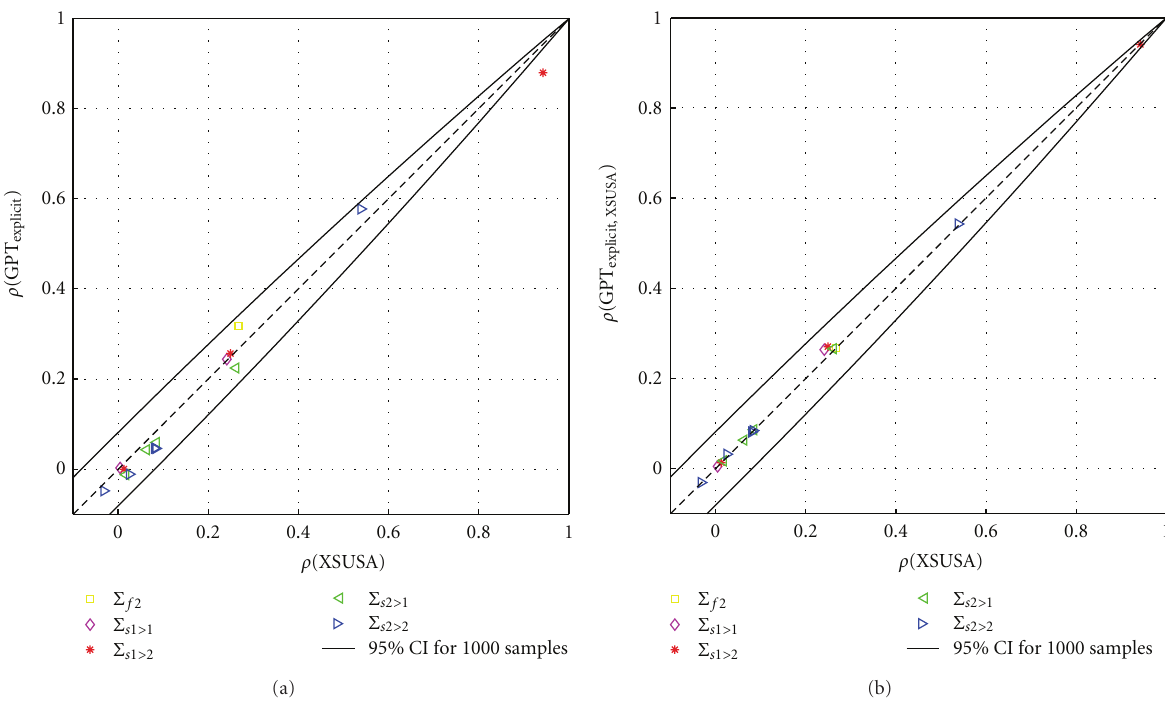
Figure 4: Correlation coe ffi cients calculated by XSUSA compared to those calculated by SCALE. (a) Only the explicit e ff ect is represented in the SCALE coe ffi cients. (b) The explicit e ff ect and the XSUSA perturbation factors are